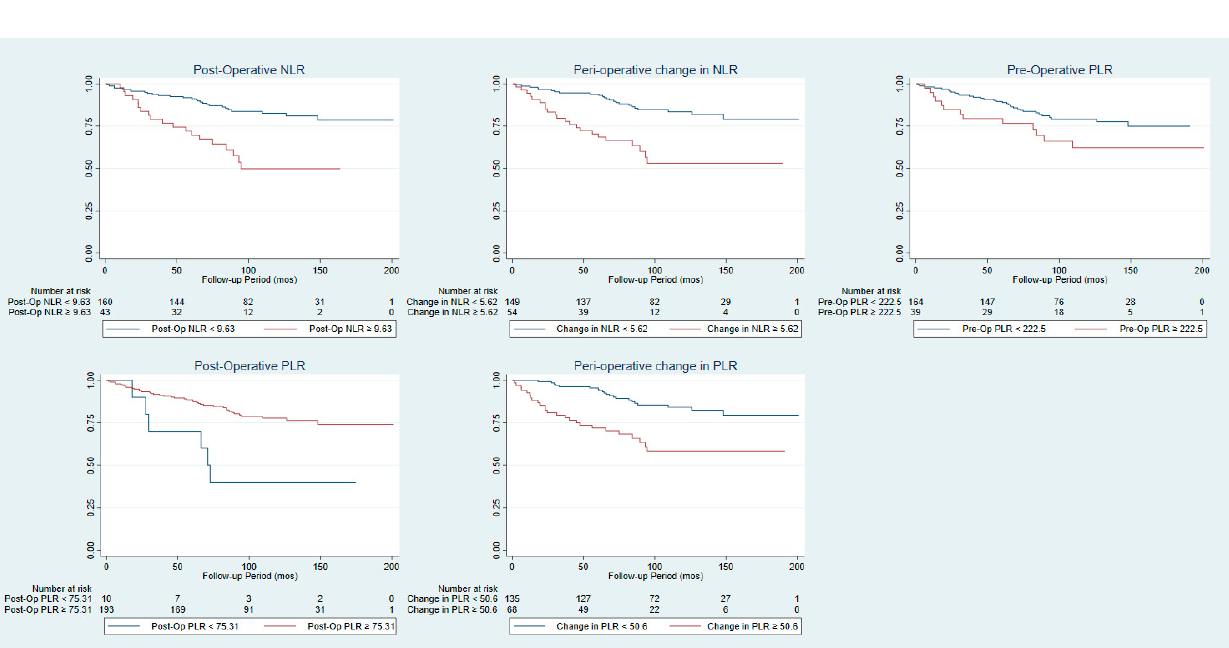
Figure 1. Kaplan–Meier curves comparing overall survival of patients with various cut-o ff s for post- operative NLR, peri-operative change in NLR, pre-operative PLR, post-operative PLR and peri-op- erative change in